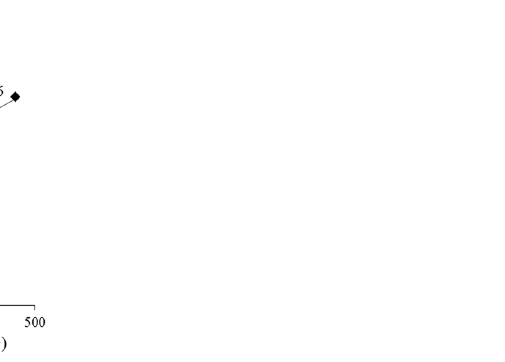
Figure 4. Linear regression model for quantitative analysis of Sudan I in paprika powder by 1 H solution NMR